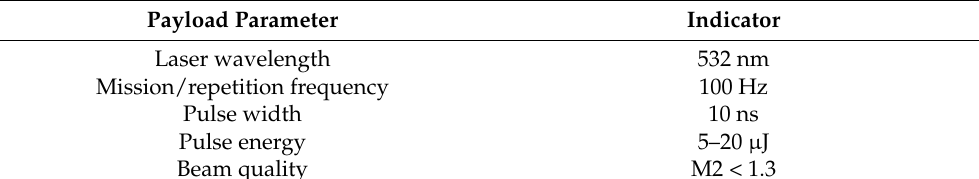
Table 1. Payload parameters of SBLS-1.